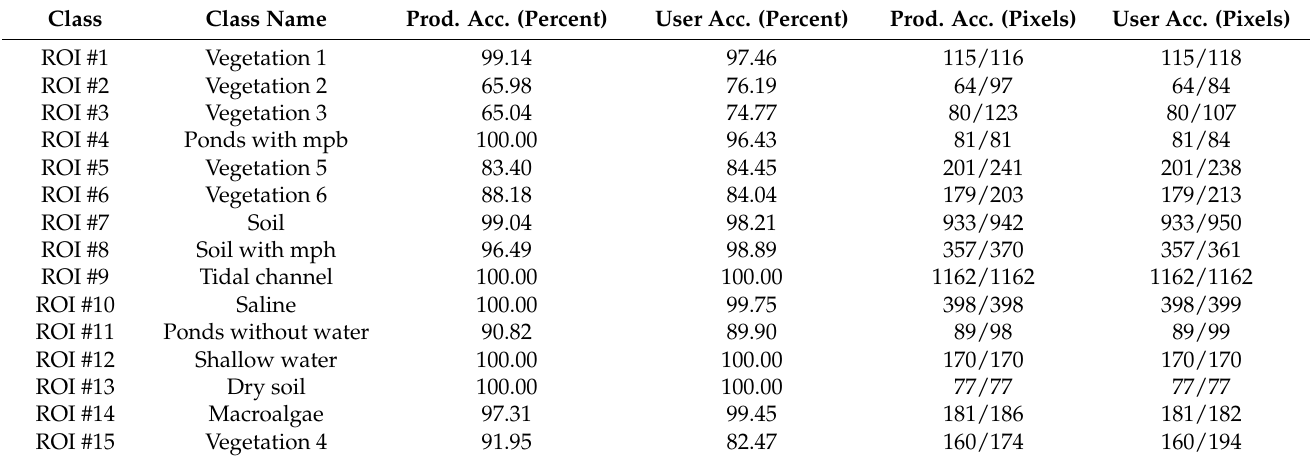
Table A5. Report for the accuracy of the comparison of classification results to R20, the random samples group using 20% of total pixels as reference. The table summarizes the producer accuracy and user accuracy in percentage and pixels for each class.